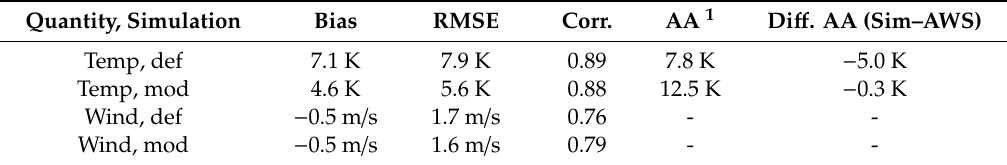
Figure 6. Temperature ( upper panel ) and wind speed ( lower panel ) for the period 17 April to 15 May 1997 for automatic weather station (AWS) A4 (15 min values, black), the standard turbulence parameterization (def, red), and the modified turbulence parameterization (mod, blue). Wind and temperature for the AWS were taken at 2 m height; the simulated data are the 2 m temperature and the 10 m wind (hourly values). Black squares mark the times of the katabatic wind flights. Table 2. Comparison of CCLM simulations (sim) with AWS A4 for April and May 1997 for temperature and wind speed (RMSE: root mean square error, corr: correlation; AA: daily temperature amplitude, def: standard turbulence parameterization, mod: modified turbulence